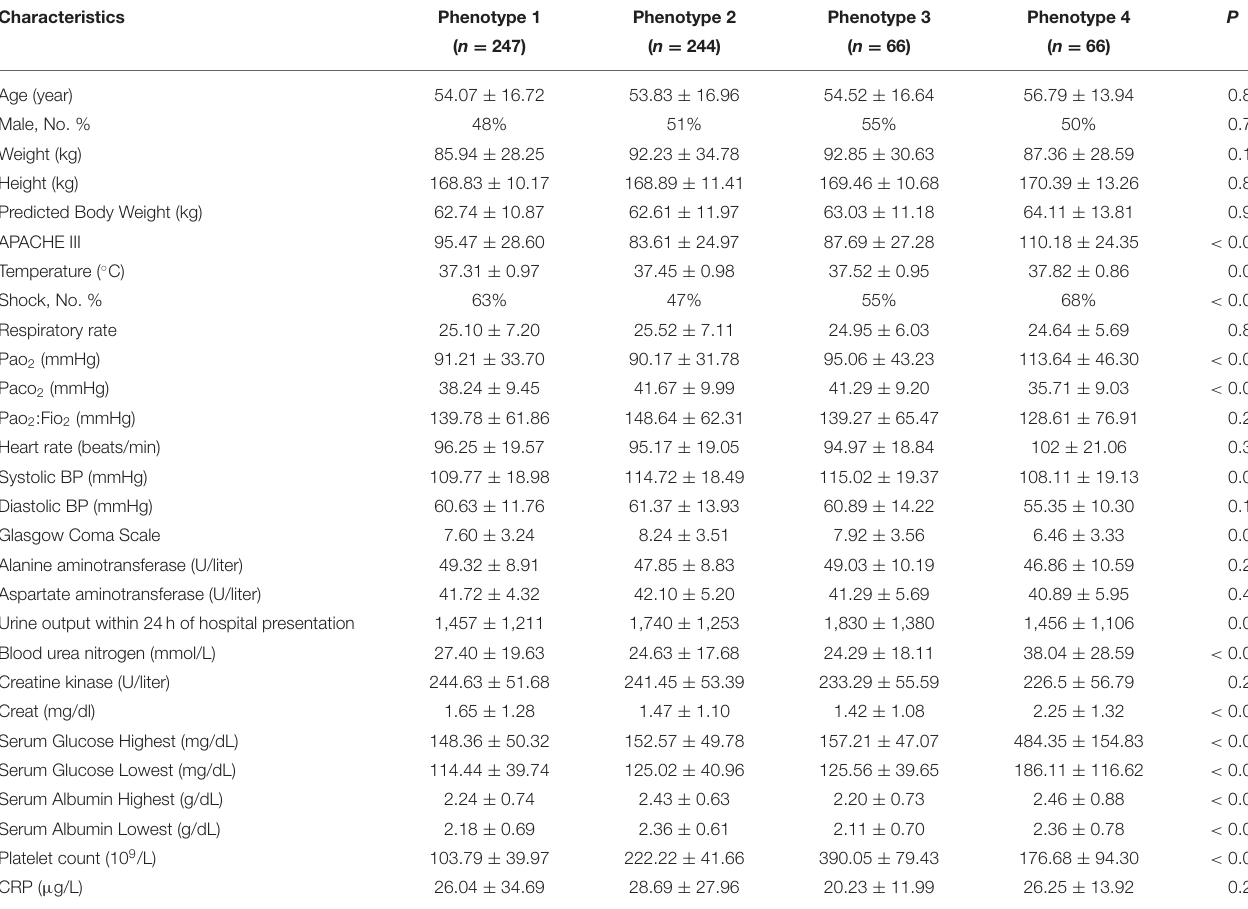
TABLE 2 | Clinical characteristics variations in different